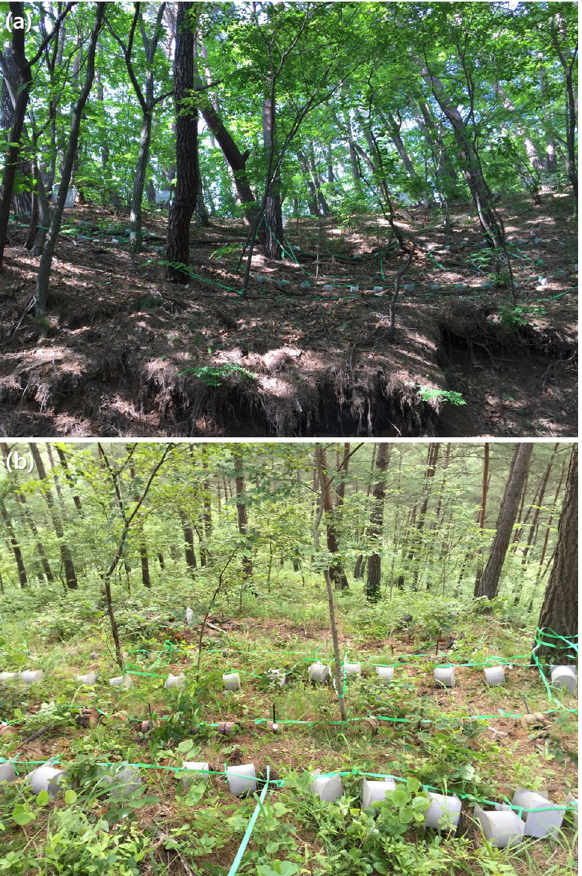
Figure 1. Photographs of the initial deadwood samples in site 1 ( a ) and site 8 ( b ) (photograph by Seongjun